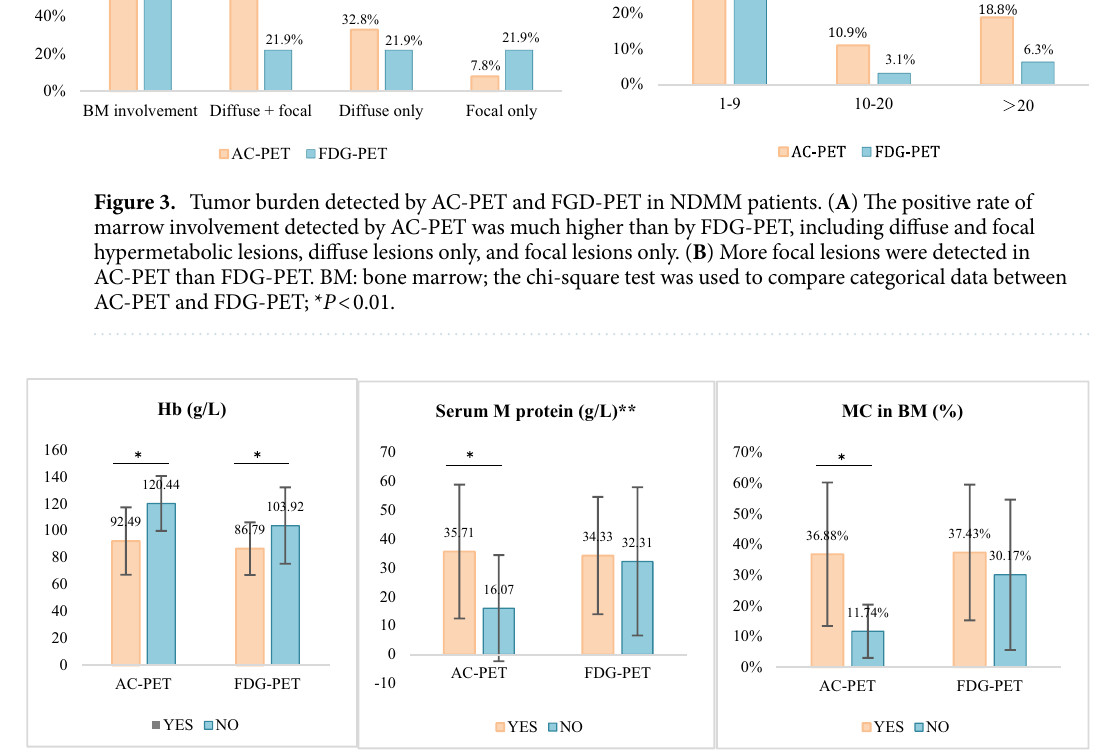
Figure 4. Correlation of fiffuse bone marrow uptake in AC-PET and FDG-PET with tumor burden. YES, patients with diffuse high marrow uptake; No, patients with negative marrow uptake; Hb, hemoglobin; **, IgG and IgA only; MC, myeloma cells; BM, bone marrow; differences of continuous variables with a normal distribution were assessed using independent-sample t -test, * P <